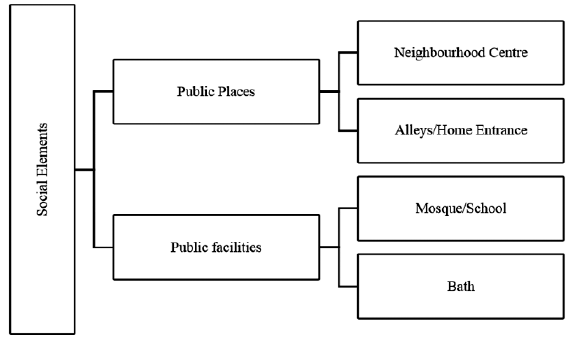
fig. 4. Elements of social life in historical neighbourhoods of